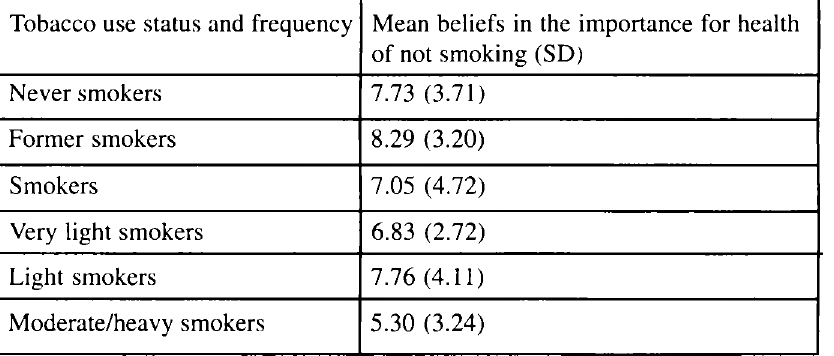
Table 2: Mean beliefs in the importance for health of not smoking Tobacco use status and frequency Mean beliefs in the importance for health